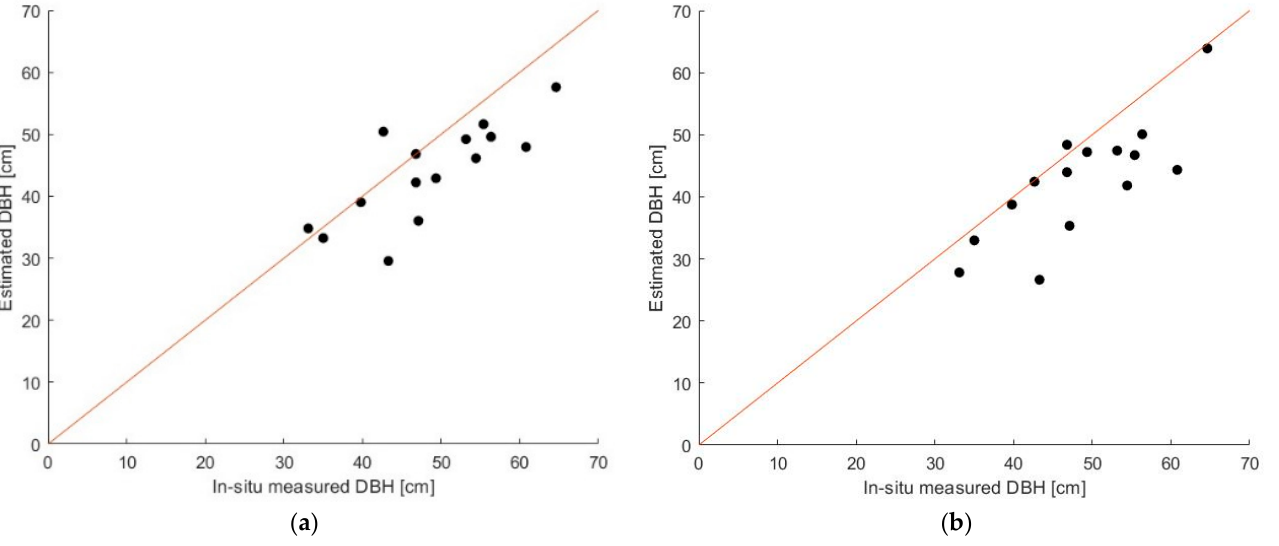
Figure 6. The scatter plot of the DBH. Ground truth on the x -axis. ( a ) Scenario 1 estimates on the y -axis. ( b ) Scenario 2 estimates on the y -axis.